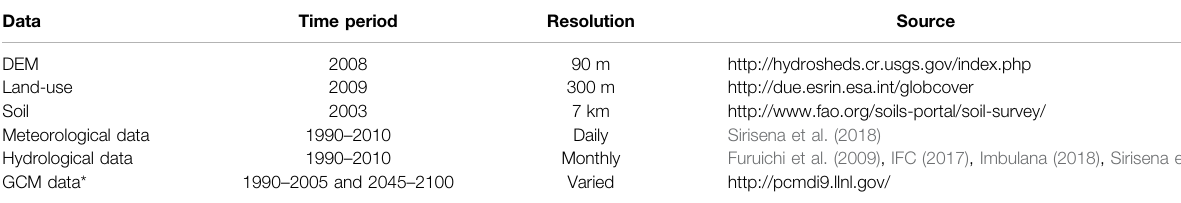
TABLE 1 | Data used in this study.